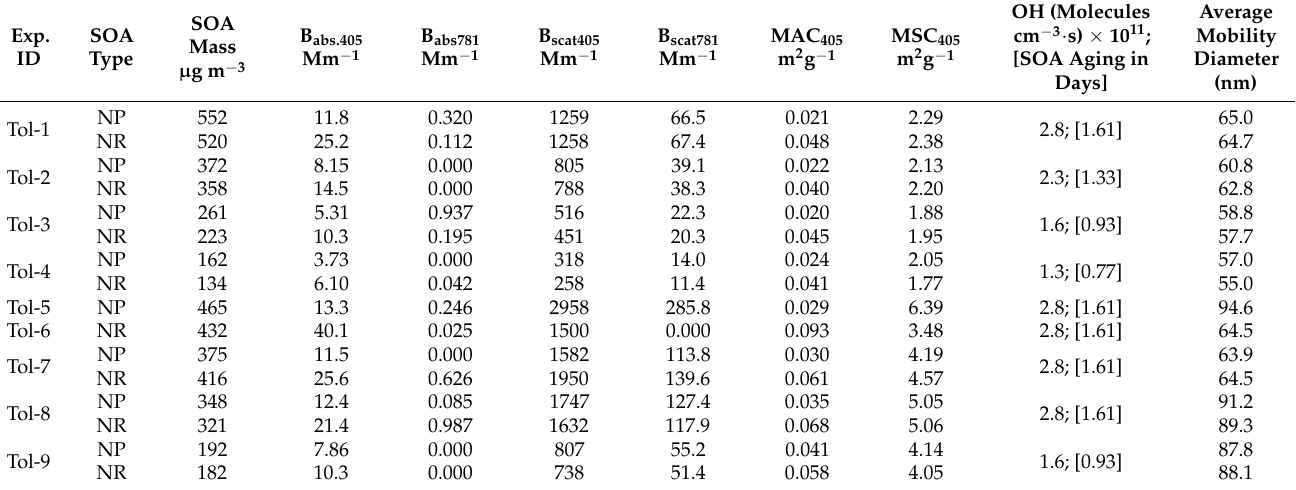
Table 2. Summary of experimental